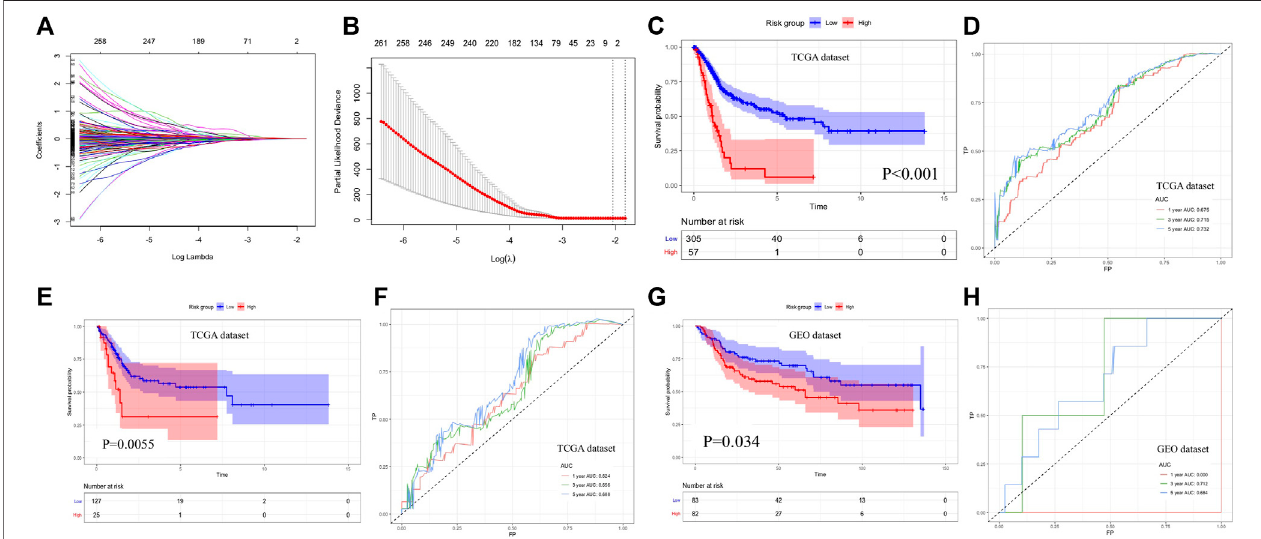
FIGURE 6 | Construction and evaluation of prognostic signature. (A, B) LASSO regression analysis for screening candidate genes. (C, D) Overall survival analysis andtime-dependentROCcurvesofprognosticsignatureforpredicting1-year,3-year,and5-yearsurvivalintheTCGAdatabase. (E,F) Survivalanalysisresultandtime- dependent ROC curves for internal validation. (G, H) Survival analysis result and time-dependent ROC curves for external validation with the GEO database. LASSO: least absolute shrinkage and selection operator, ROC: receiver operating characteristic, and GEO: gene expression omnibus.